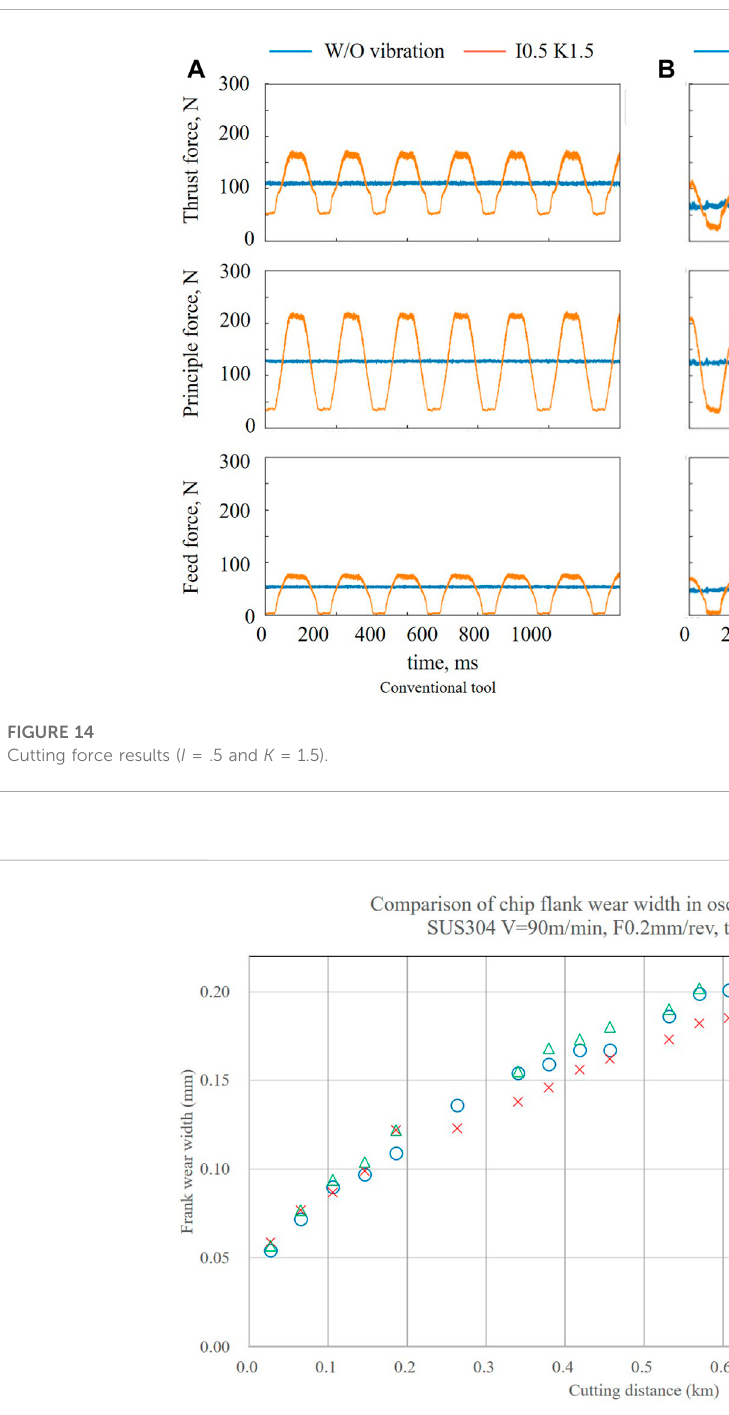
cutting can be reduced by designing an appropriate tool shape. The surface roughness of the proposed tool was signi fi cantly lower than that of the conventional tool because the straight partofthe tool fi lled the gap and reduced the convexity to the point at which the gap between the